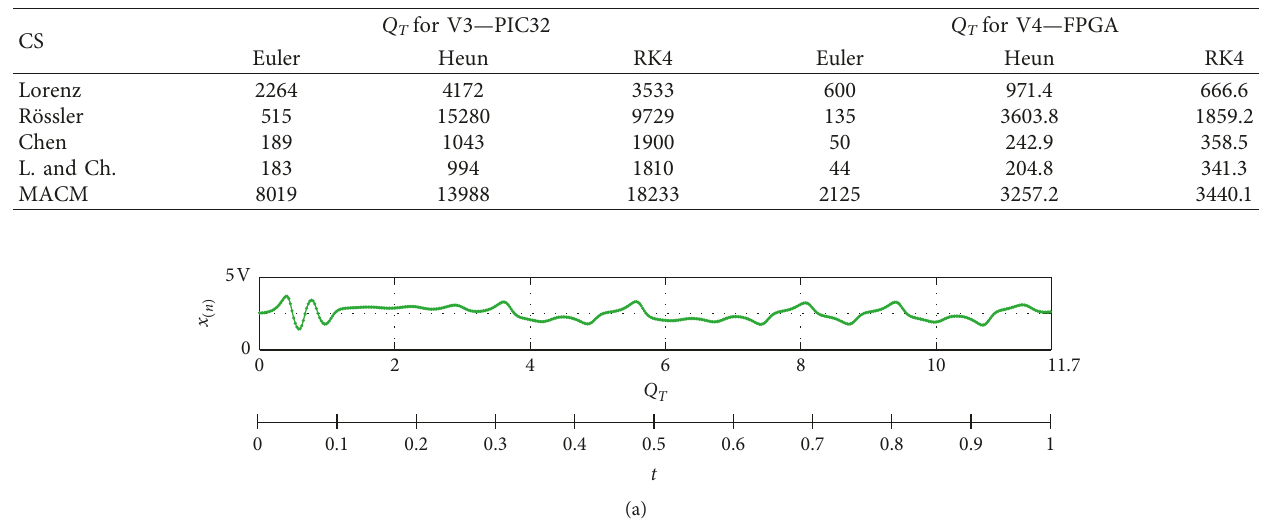
T of V3-V4 for 3D Lorenz, R¨ossler, Chen, Liu and Chen, and MACM CSs in their DVs using